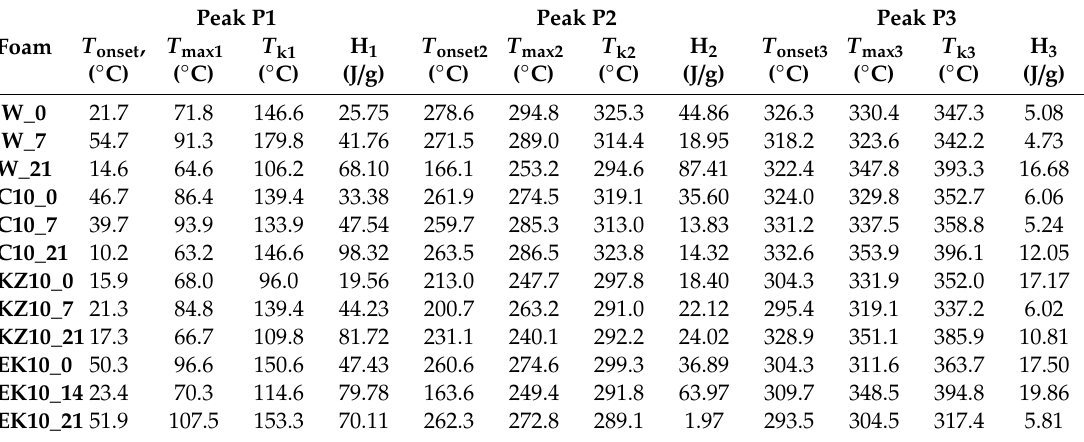
Table 7. Values of thermal transformations of W, C, KZ, EK foams